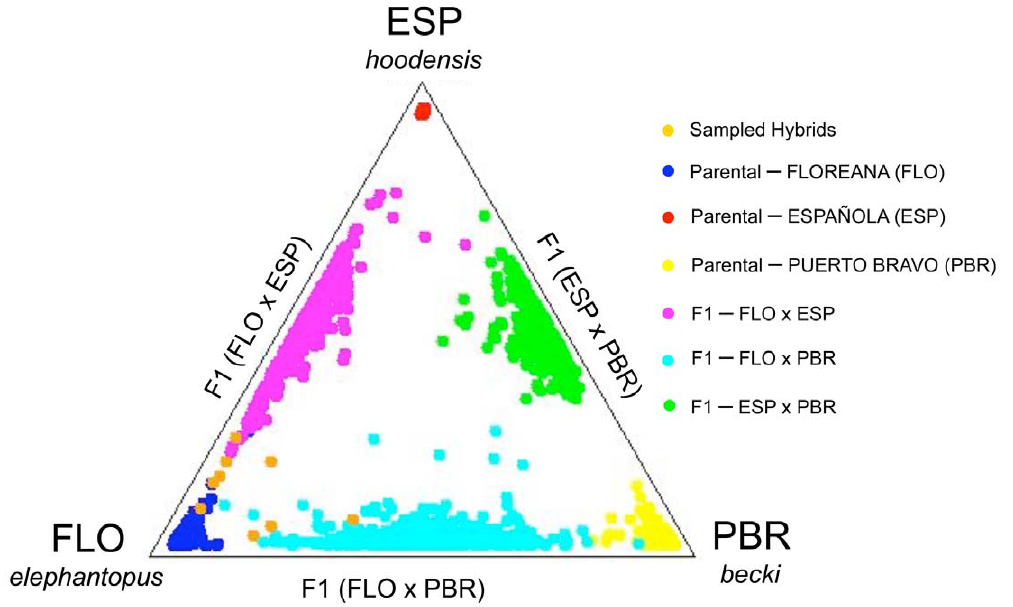
Figure 2. Patterns of Floreana mixed ancestry as revealed by genotype simulations and Bayesian clustering analyses. STRUCTURE triangle plot revealing clustering patterns of individuals of Floreana mixed ancestry with simulated parental and F1 genotypes for all possible pairwise comparisons involving Puerto Bravo (PBR), Floreana (FLO) and Espan˜ola (ESP) populations. For display purposes, only simulated parental and F1 distributions are shown. Colors according to embedded legend.